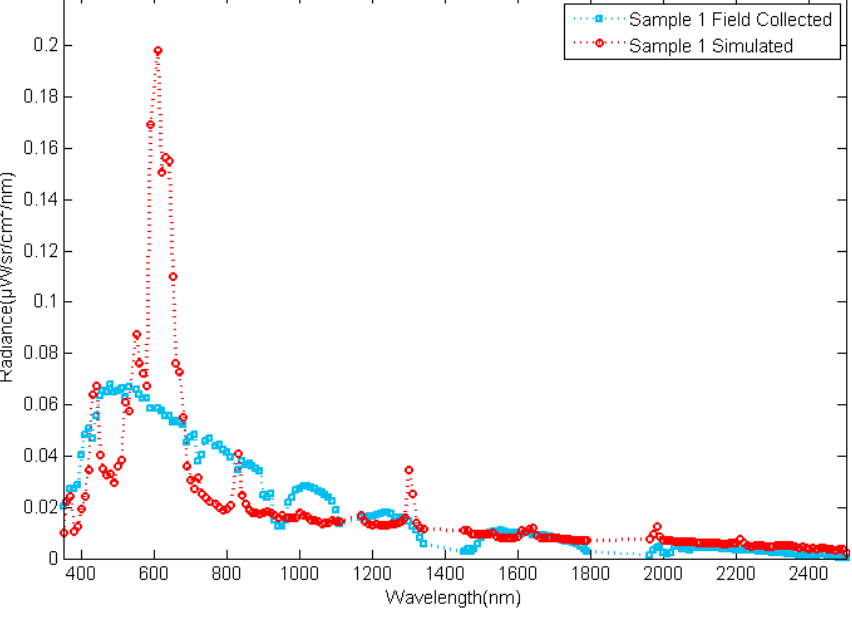
Figure 12. The radiance reflected by targets.